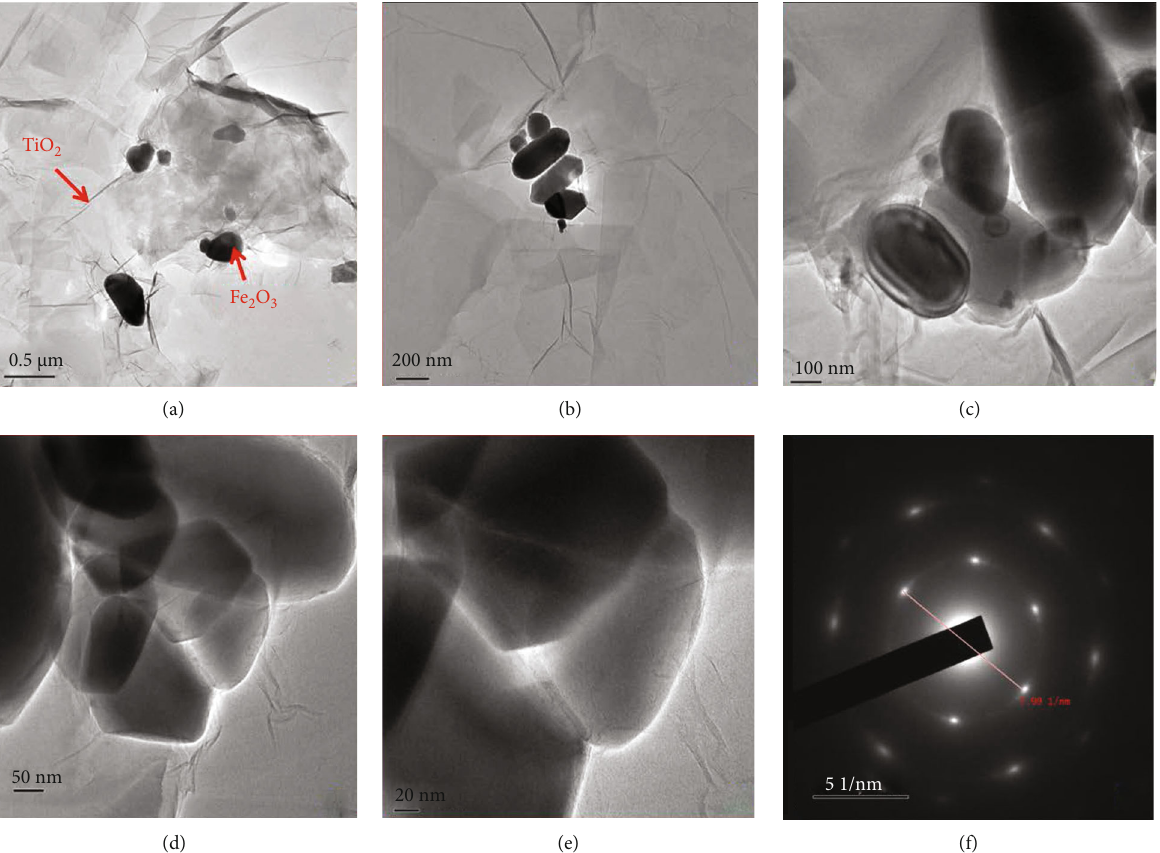
Figure 6: HRTEM image of as synthesized GFT oxide nanomaterial, (a) – (e) 0.5 μ m to 20nm, (f) crystal fringes obtained from SAED